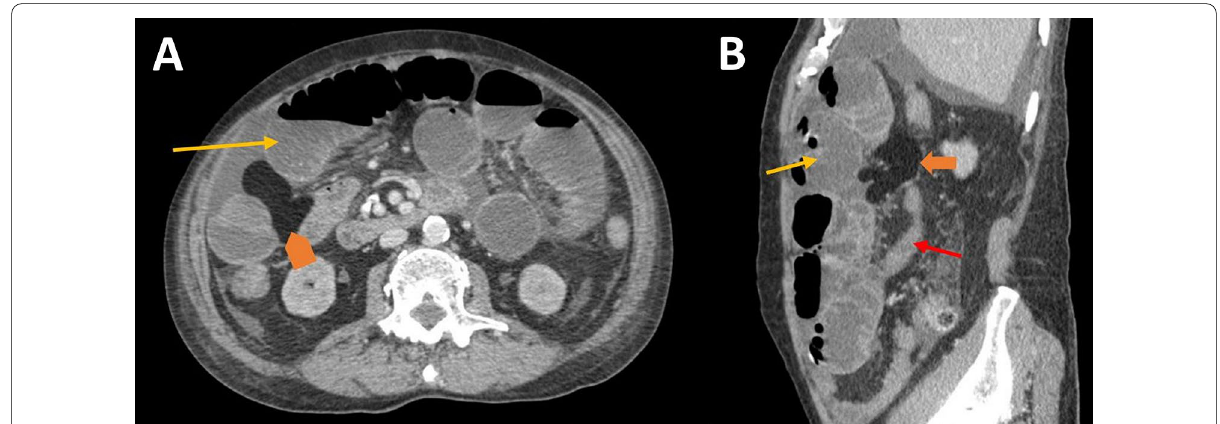
Fig. 2 Post-contrast CT scan of the abdomen in A axial, B sagittal view showing multiple coalescing lobulated extraluminal lesions (orange arrow) encircling part of a small bowel, which is comparatively more hypoattenuating in comparison with the surrounding mesenteric and subcutaneous fat, forming transitional zone. The proximal small bowel loops are dilated (yellow arrow) with completely collapsed distal small (red arrow) and large bowel